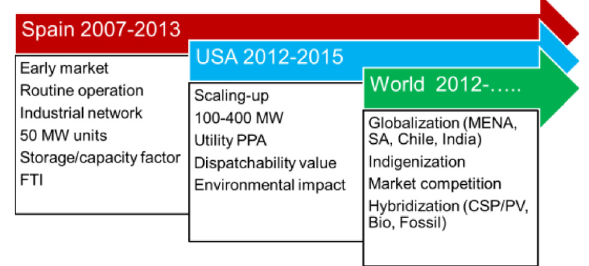
Fig. 2. Concentrating Solar Power (CSP) market development waves since